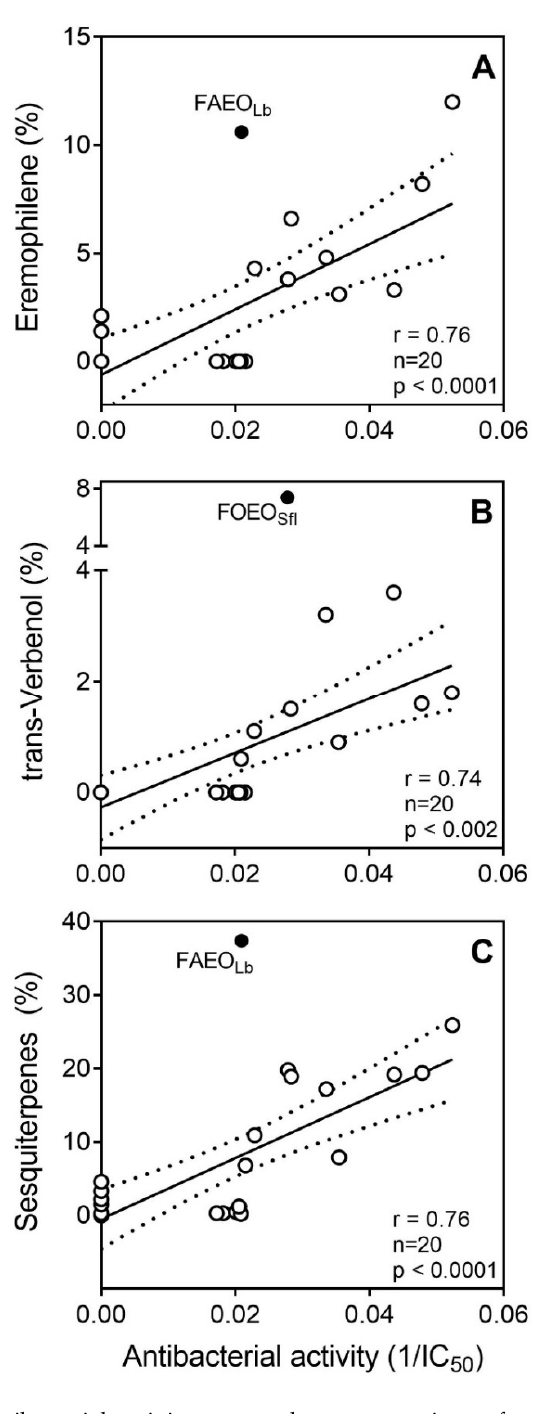
Figure 2. Plots of antibacterial activity versus the concentrations of eremophilene Panel ( A ), trans -verbenol Panel ( B ), and total sesquiterpene hydrocarbons Panel ( C ) in the EOs based on GC-MS data. Activities are represented as inverse (1/IC 50 ) values to account for the four inactive EO samples from F. akitschkensis . These samples, indicated as closed circles, were omitted from the regression calculation and are shown as outliers. Dashed lines indicate area of the 95% confidence band. FAEO Lb , EO isolated from F. akitsckensis leaves at the budding stage; FOEO Sfl , EO isolated from F. ovina stems at the flowering